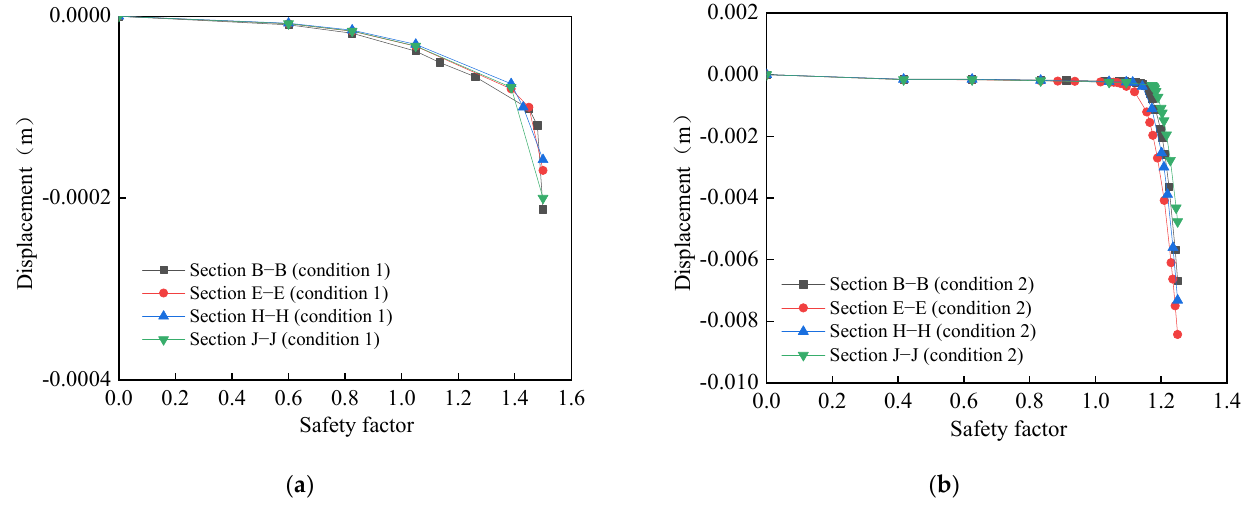
Figure 13. Relationship between safety factor and displacement of dangerous sections under different conditions. ( a ) Condition 1; ( b ) condition 2.